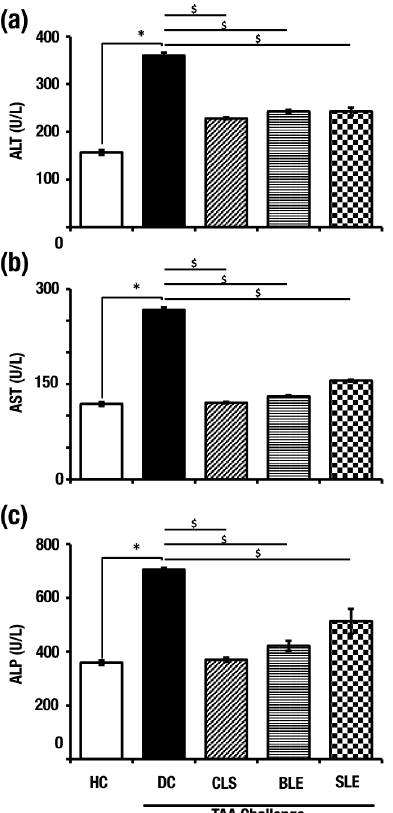
Figure 2. Selected aqueous extracts (CLS, BLE and SLE) protect the liver from TAA-induced damage by reducing the leakage of liver enzymes at the end of the treatment period. ( a ) Serum ALT levels, ( b ) serum AST levels and ( c ) serum ALP levels of HC, DC and after treatments of aqueous extracts along with TAA challenge. Error bars represent standard errors of the mean (SEM) in each group ( n = 5). The statistical significance of results has been shown in two ways; (i) disease induction effect during the TAA challenge (HC vs. DC), (ii) O. octandra treatment effect (DC vs. CLS, BLE and SLE) was analyzed with one-way ANOVA followed by the Dunnett’s test. $, significant decrease; $, p = 0.05 to 0.01. *, significant increase; *, p = 0.05 to